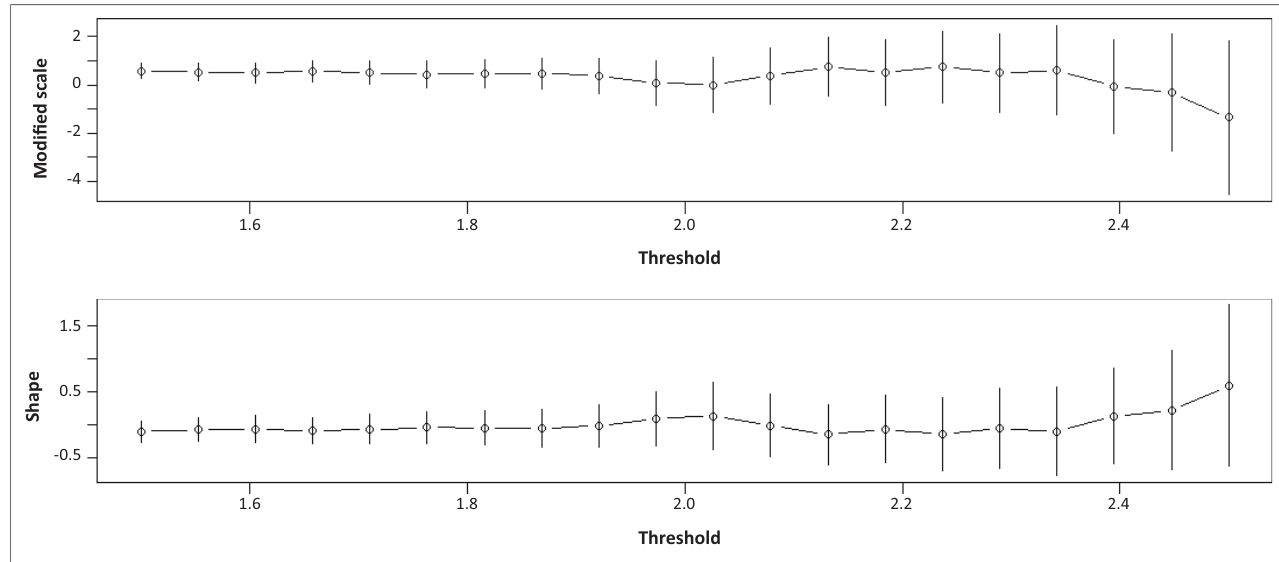
FIGURE 5: Parameter stability plot of asymmetric power auto-regressive conditional heteroscedastic (1,1) model (normal innovations) residuals. TABLE 4: Maximum likelihood estimates of the generalised Pareto distribution for the asymmetric power auto-regressive conditional heteroscedastic (1,1)–generalised Pareto distribution model. EVT threshold t Sample size